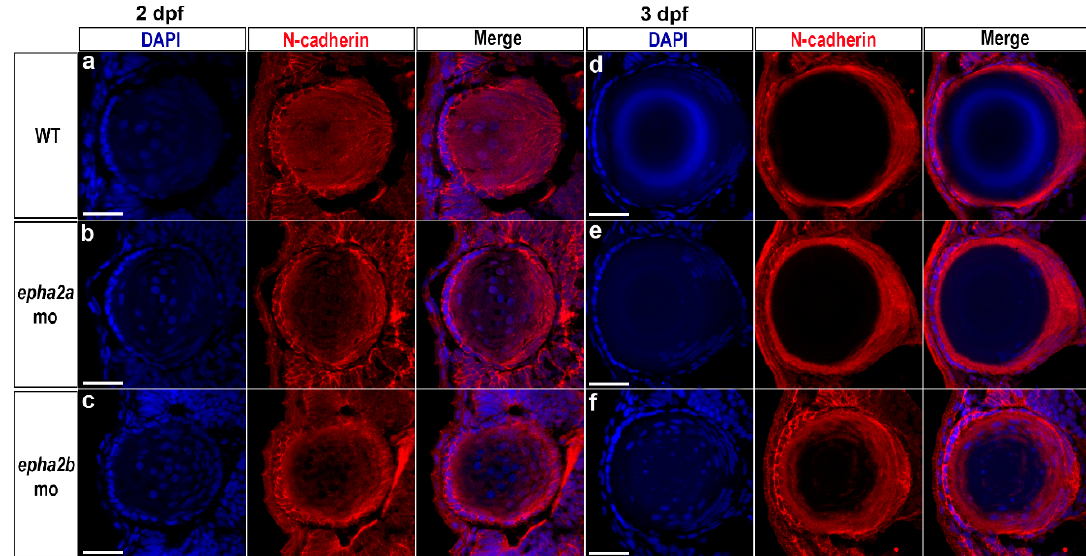
Figure 4. Lens abnormalities in epha2b morphant zebrafish. To assess lens development, N-cadherin (red) and DAPI (blue) staining were performed on lens sections from wild-type (WT), epha2a , and epha2b morphant zebrafish at 2 dpf ( a–c ) and 3 dpf ( d–f ); this permitted visualisation of the lens fibre cells and cell nuclei, respectively. At 2 dpf, there were no apparent differences between the morphants and uninjected wild-type siblings. At 3 dpf, the epha2b morphant showed retention of fibre cell nuclei within the lens ( f ), which was not observed in age-matched wild-type ( d ) and epha2a morphant larvae. Scale bars = 25 µm.